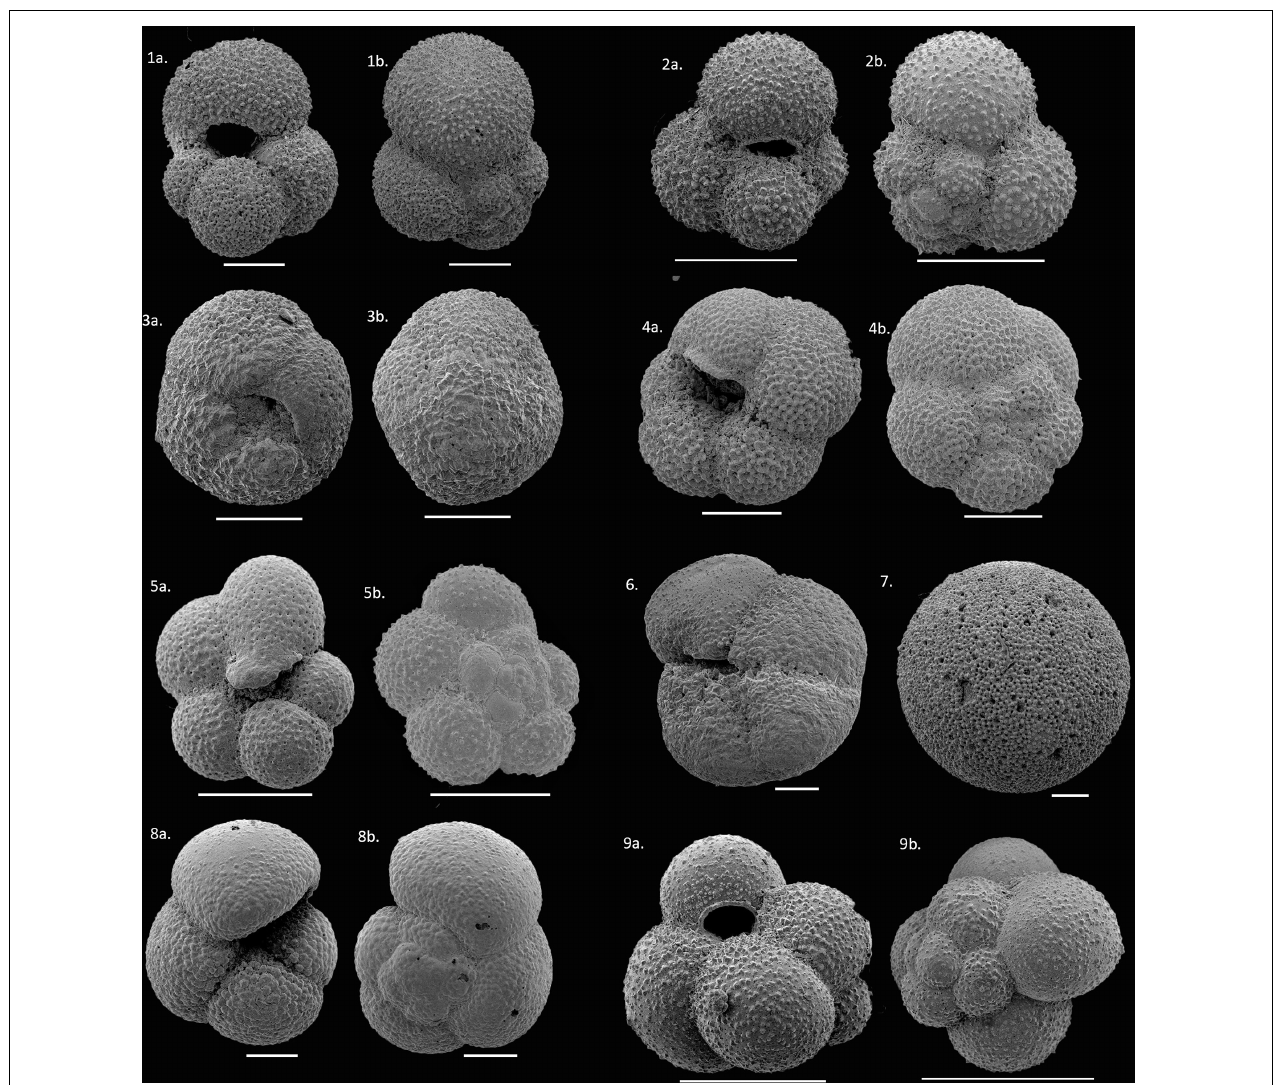
FIGURE 3 | Scanning Electron Micrograph (SEM) images of planktic foraminifera species observed in the present study. (1a,b) Globigerina bulloides ( G . bulloides ), (2a,b) Globigerinita glutinata ( G . glutinata ), (3a,b) Neogloboquadrina pachyderma ( N . pachyderma ), (4a,b) Neogloboquadrina incompta ( N . incompta ), (5a,b) Turborotalita quinqueloba ( T . quinqueloba ), (6) Globorotalia scitula ( G . scitula ), (7) Orbulina sp. (8a,b) Globorotalia inflata ( G . inflata ), (9a,b) Globigerinita uvula ( G . uvula ); Scale bars 100 µ m.